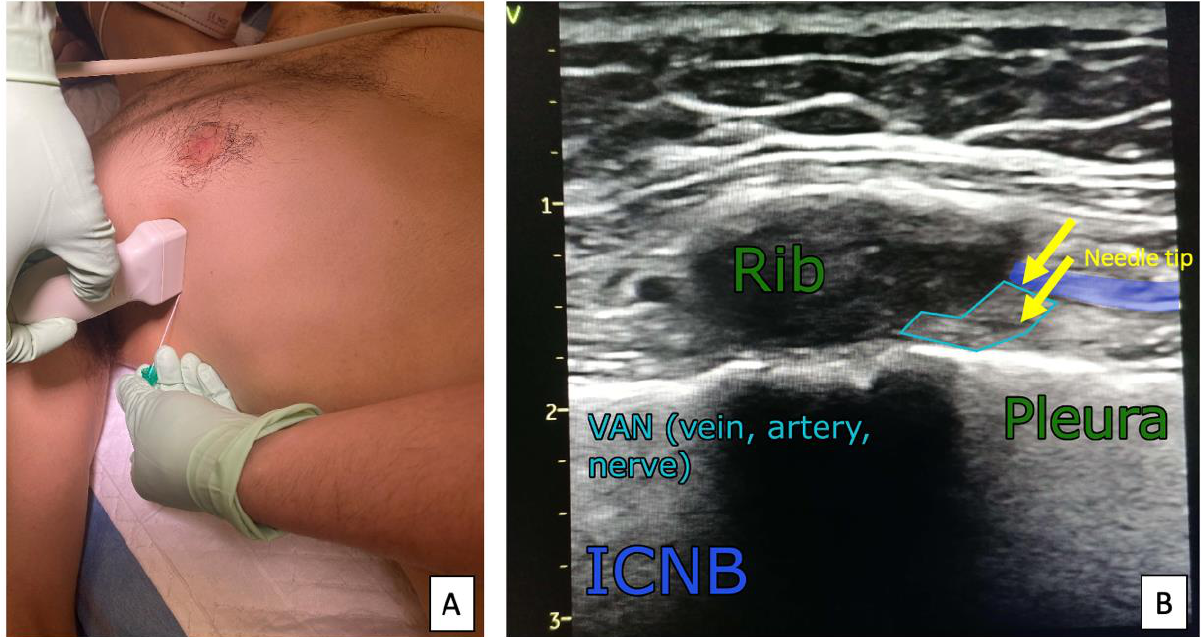
Figure 7. Ultrasound transducer positioning ( A ) and sonoanatomy of the ICNB block ( B ). Application: ICNB blocks can achieve adjuvant analgesia after traumatic rib fractures, and in thoracotomy; maintenance of pleural drainage; neuralgia caused, for example, by herpes zoster; cancer metastases; pain relief after extensive epigastric procedures; splenectomy; cholecystectomy; and nephrectomy